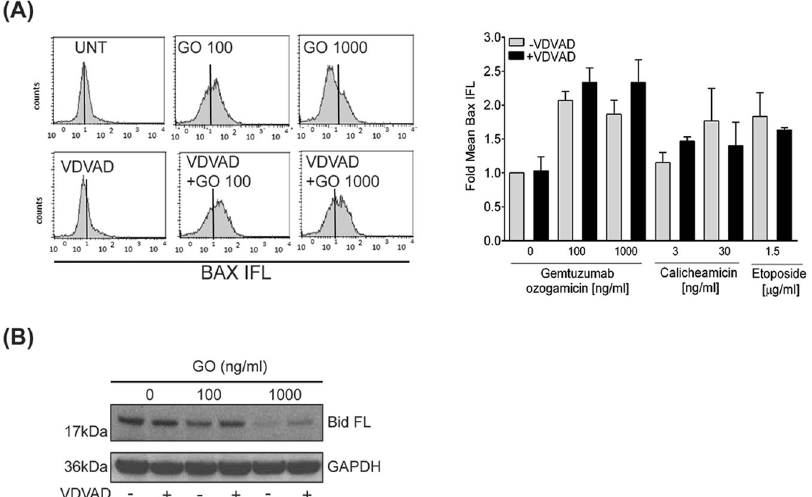
Fig. 3 Caspase-2-mediated apoptotic signaling upon GO-treatment of AML cells does not involve conformational change of Bax. A Bax conformational change was studied in HL60 cells by fl ow cytometry after 48 h treatment with GO, calicheamicin or etoposide alone or combined with the caspase-2 inhibitor z-VDVAD-fmk (10 µM, 2 h pre-incubation) . Left panel: Bax conformational change is shown as a peak- shift to the right in the fl ow cytometry histogram. Right panel : Quanti fi cation of Bax-associated mean fl uorescence intensity. Data is given as fold increase to untreated cells. B Cleavage of full-length Bid was analyzed by immunoblotting at 24 h post treatment with indicated doses of GO with or without 2 h pre-incubation with z-VDVAD-fmk (10 µM). GAPDH was used as loading